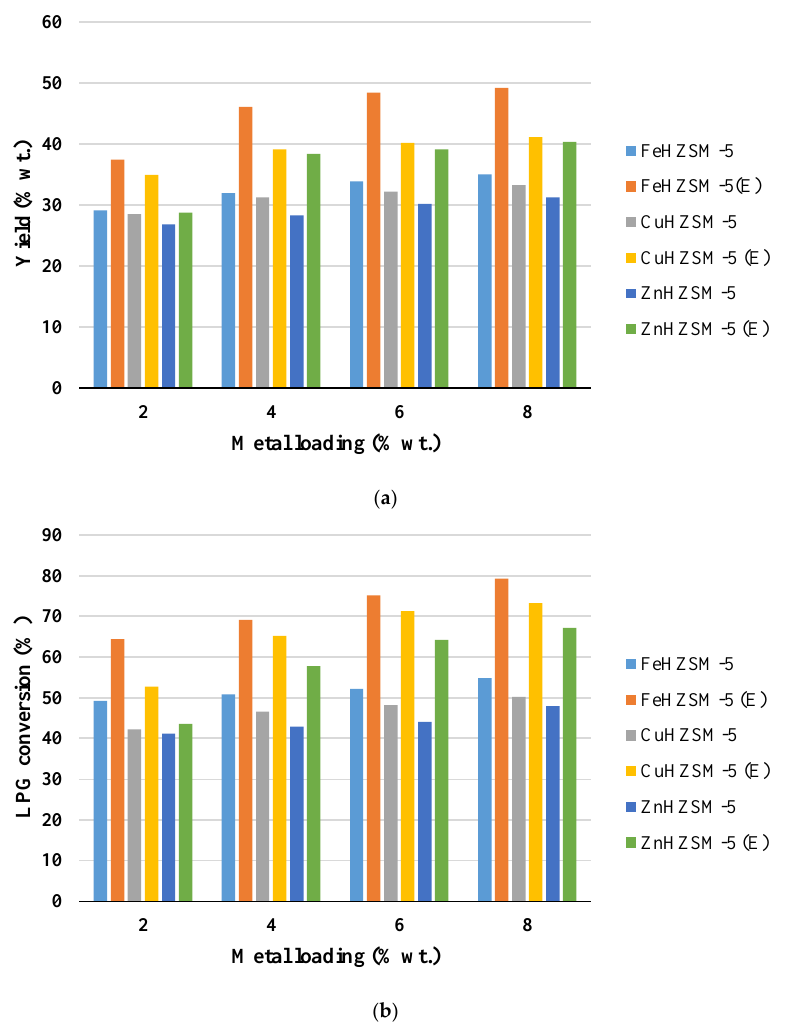
Figure 12. Effect of metal loading in oxidative dehydrogenation for FeHZSM-5, CuHZSM-5 and ZnHZSM-5 catalysts in presence and absence of electric field ( a ) Olefin yield; ( b ) LPG conversion: 100 mg catalyst, 625 ◦ C, 6 mA, 10 mm gap